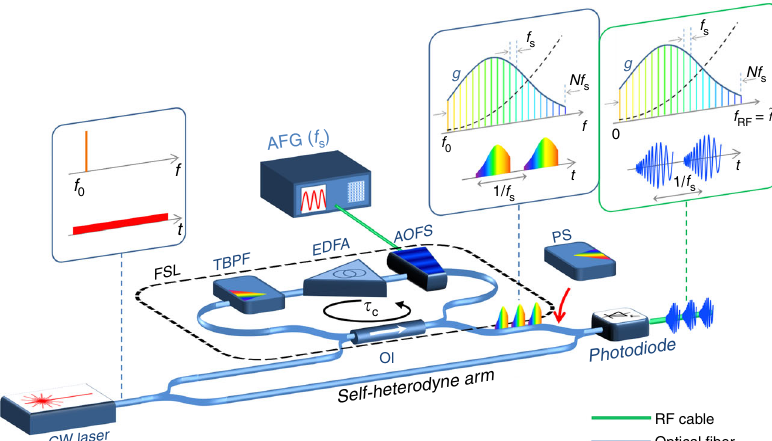
Fig. 2 Schematic of the proposed photonic architecture for RFCW generation. A fi ber loop (travel time: τ c ) containing an acousto-optic frequency shifter (AOFS), an erbium-doped fi ber ampli fi er (EDFA), a tunable bandpass fi lter (TBPF), and an optical isolator (OI), is seeded by a CW laser. The AOFS is driven by a single-tone RF signal at frequency f s , produced from an arbitrary function generator (AFG). The FSL generates an optical frequency comb with a quadratic spectral phase (dashed line), corresponding in the time domain to a periodic train of time-stretched (dispersed) optical pulses. The optical waveform shape at the output of the loop can be controlled by a programmable optical spectrum pulse shaper (PS), and is then recombined with a fraction of the seed laser in a photodiode. The recombination with the seed laser produces the desired RF chirps by frequency